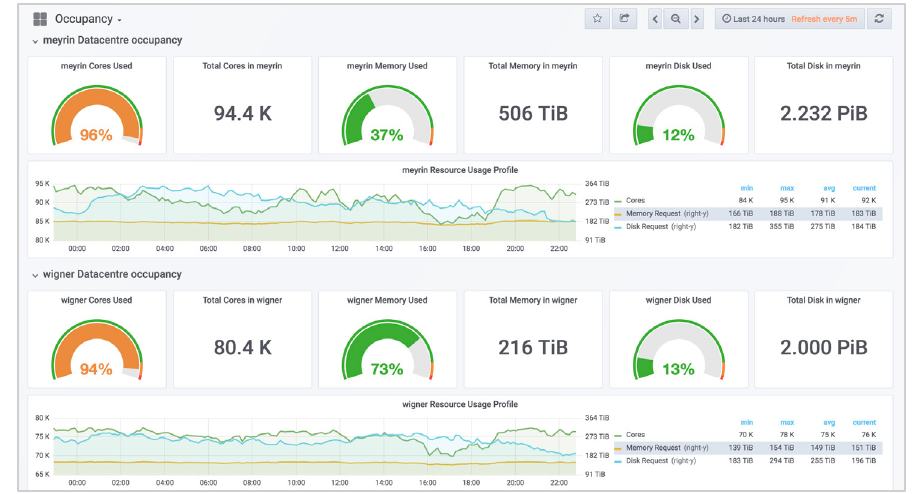
Fig. 2. Example of Dashboard of the Batch Computing Service